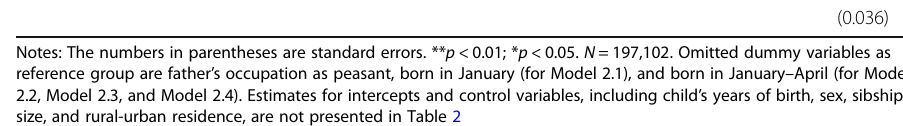
Table 2 The logistic regression of delayed school entry for one year on child ’ s birth month (Continued) Manual worker father × born in May – Aug.